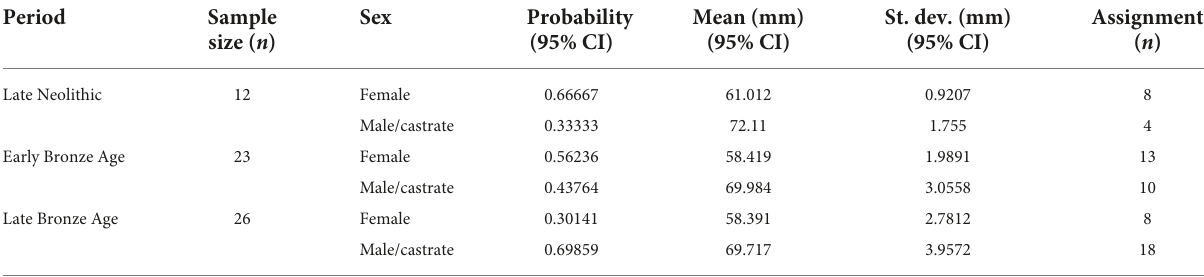
TABLE 3 Mixture analysis results of metacarpal Bd and numbers of assignment of female and male/castrate cattle in each period. Period